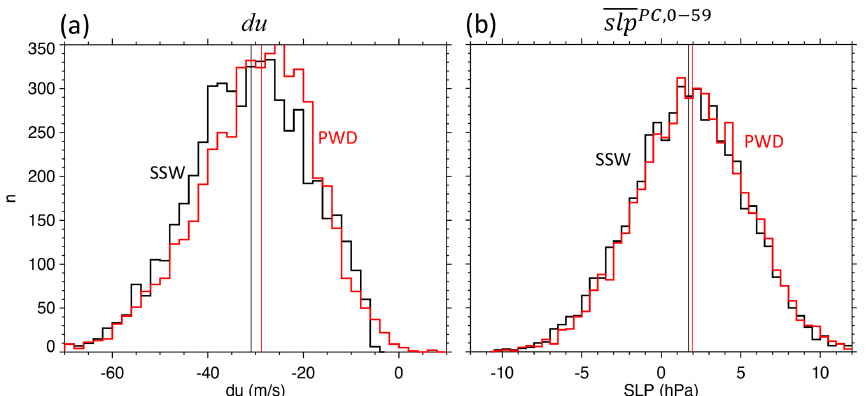
Figure 6. Response histograms of model-simulated SSWs and PWDs in the stratosphere and troposphere. Shown are responses to all (black) SSWs and (red) PWDs in terms of (a) the minimum anomalous u 1060 , du min , and (b) the polar-cap-averaged SLP following the events PC , 0 − 59 (slp ). Vertical axis gives number of events n per bin. Thin vertical lines give the medians of the distributions. PWD wave driving threshold (cid:80) F (cid:48) is 12.9d. Shown are the outcomes from 5224 SSWs and 5154 PWDs. Z crit